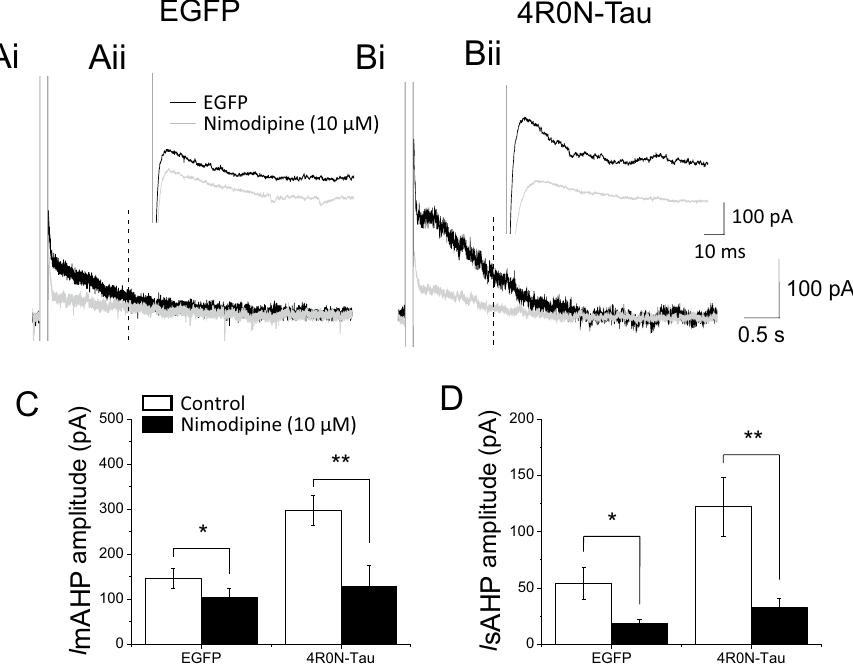
Figure 3. Enhanced Ca 2+ entry through L-type channels results in augmentation of currents underlying medium and slow AHPs in hippocampal CA1 pyramidal neurons expressing 4R0N-tau. ( Ai,Bi ) Membrane current evoked following a depolarizing voltage step to + 10 mV (100 ms duration) in absence (black trace) and presence (gray trace) of nimodipine (10 μM) in cells expressing either EGFP only ( Ai ) or 4R0N-tau ( Bi ). ( Aii,Bii ) show in higher resolution the current underlying activation of the medium AHP in the absence and presence of the L-type channel inhibitor in cells expressing EGFP ( Aii ) or 4R0N-tau ( Bii ). ( C ) Application of nimodipine (10 μM) reduced the amplitude of the current underlying the medium AHP in both EGFP- expressing (n = 4, p = 0.048) and 4R0N-tau-expressing (n = 6, p = 0.001) cells. ( D ) Nimodipine (10 μM) significantly reduced the amplitude of the current underlying the slow AHP in both EGFP-expressing (n = 4, p = 0.043) and 4R0N-tau-expressing (n = 6, p = 0.007) neurons. The effect of nimodipine was greater in 4R0N- tau-expressing neurons. p ≤ 0.05, ** p ≤